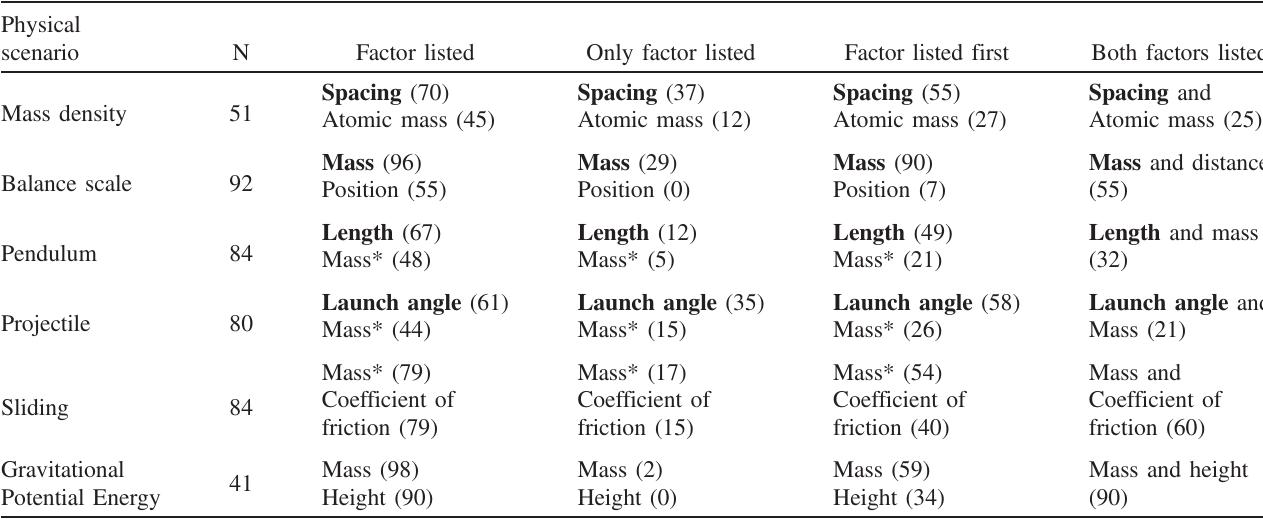
TABLE III. Experiment 1 recall condition results. The two most common factors listed as explaining the outcomes for each task. Percentages of participants explicitly listing (recalling) each combination are in parentheses. The factors with significantly relatively higher accessibility (strength) are in bold. Note that the factors with asterisks are not physically correct.